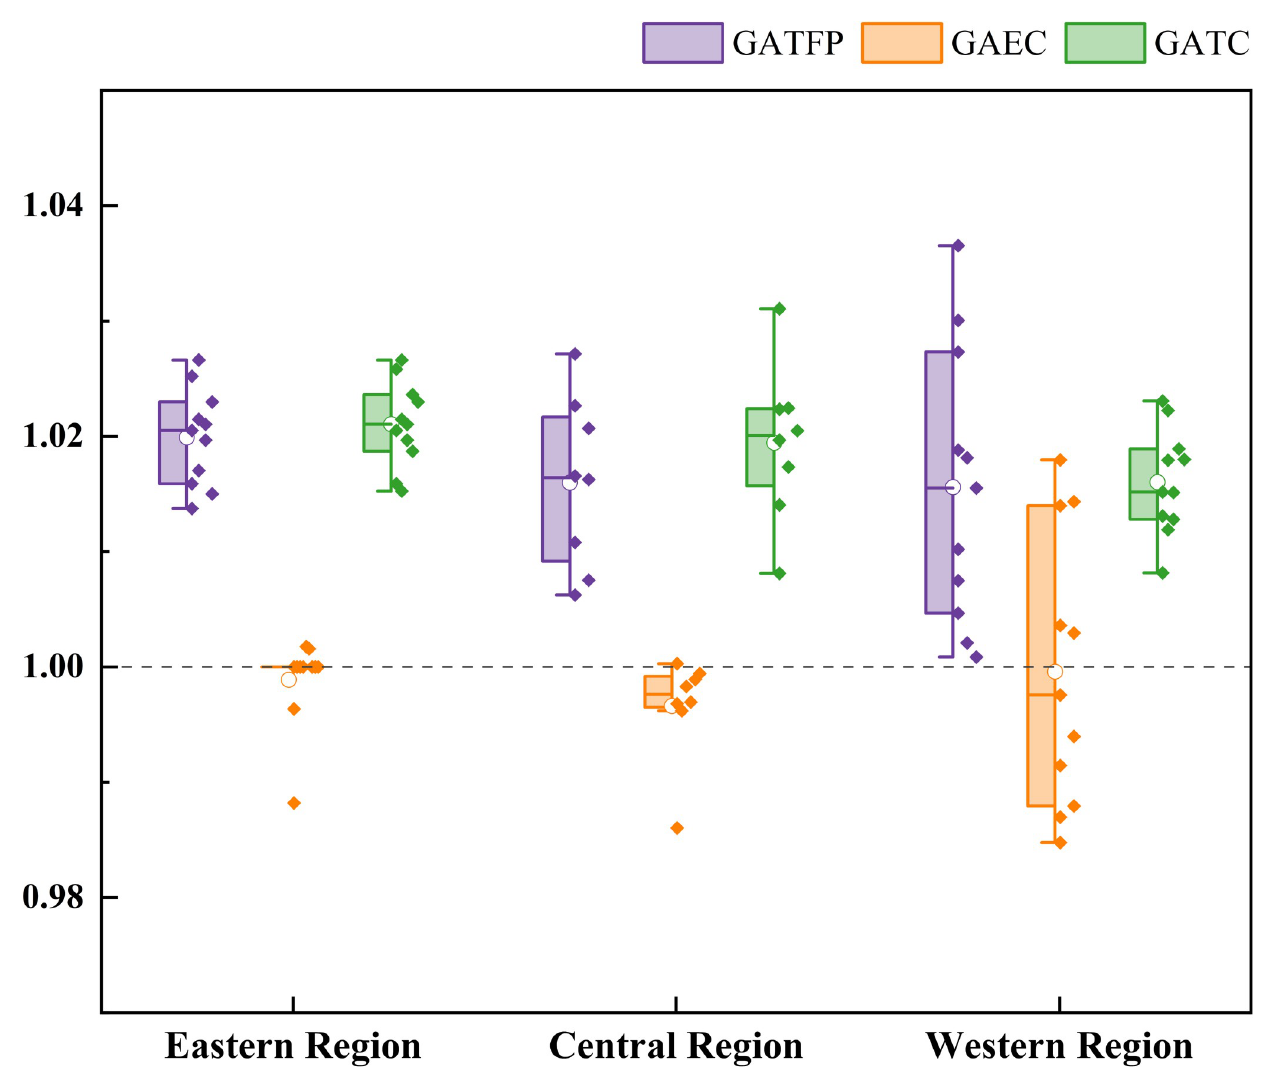
Fig 11. GATFP of the three regions and its